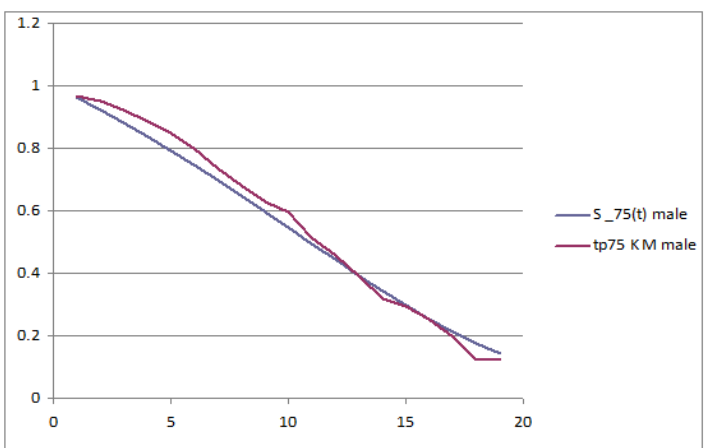
Figure 1. Females, old generation.